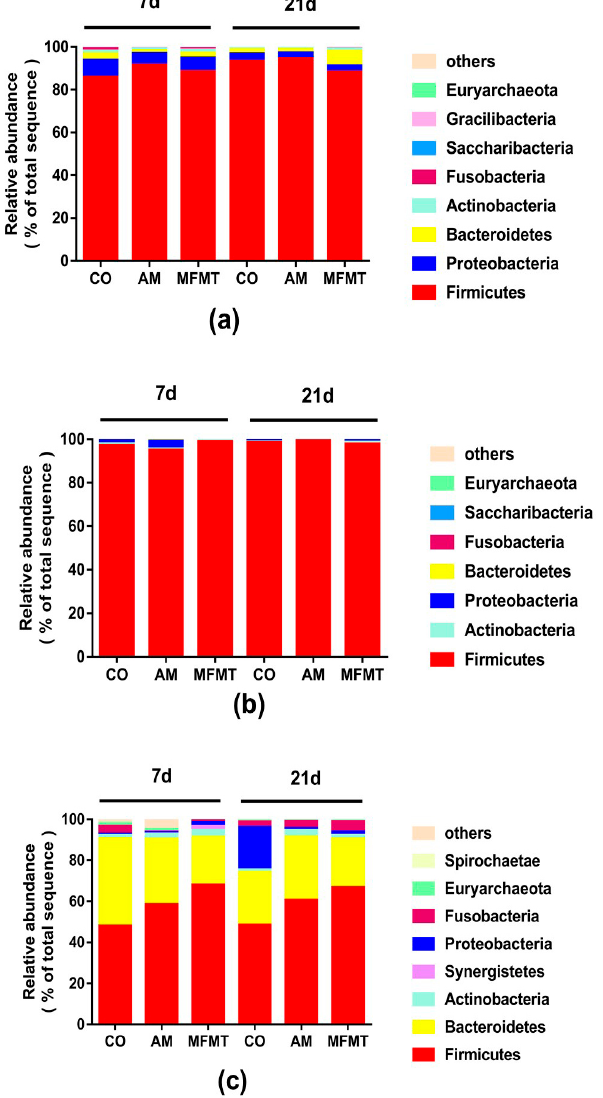
Figure 1. Relative abundances of the microbial phylum in the stomach ( a ), ileum ( b ), and colon ( c ) of piglets in the maternal fecal microbiota transplantation (MFMT), amoxicillin (AM), and control (CO) groups.